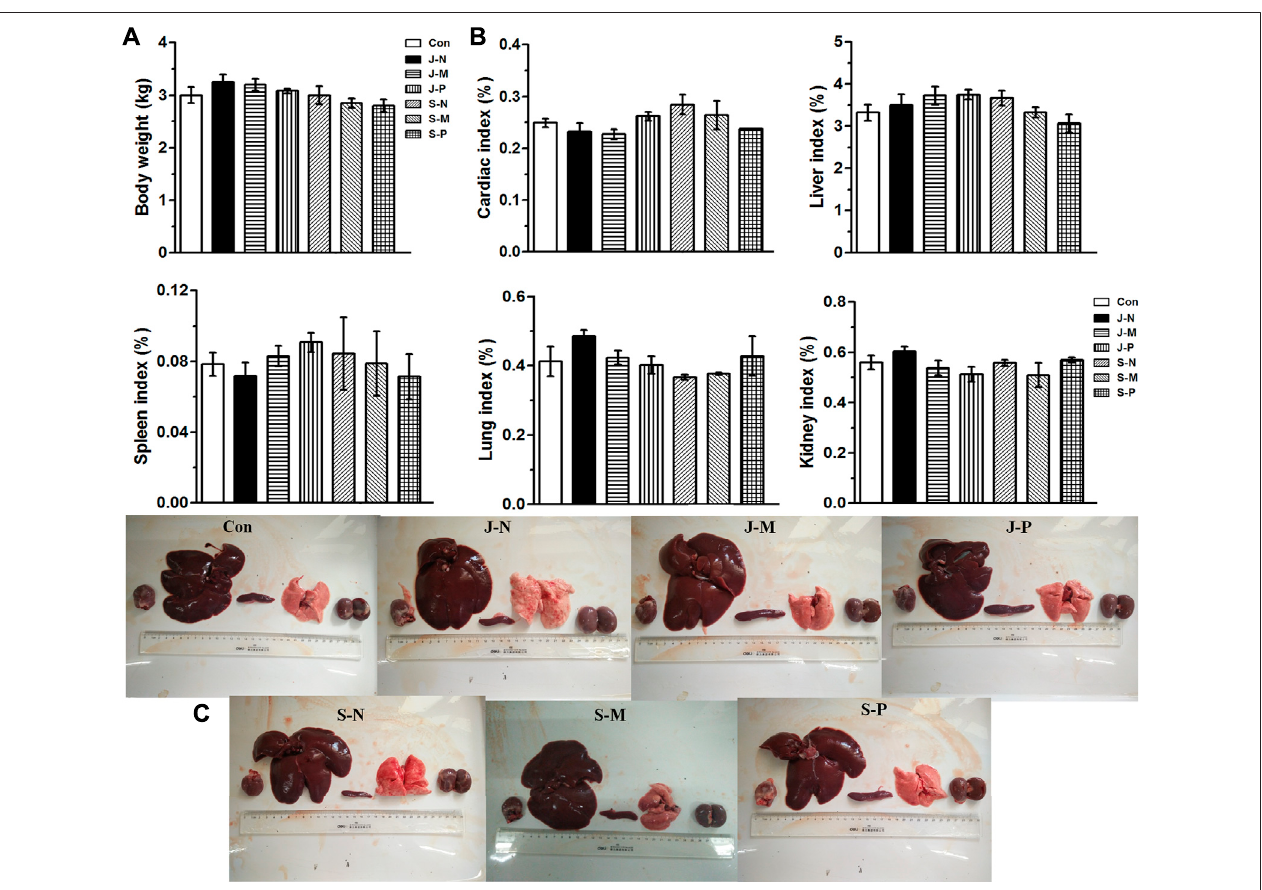
FIGURE6| EffectsofdifferentPALsat30 daysafterinjectionon (A) bodyweight; (B) organcoef fi cient,includingcardiacindex,liverindex,spleenindex,lungindex, and kidneyindex; (C) photographsofvitalorgans(heart,liver,spleen,lungs, andkidneys)inNewZealandrabbits(n (cid:2) 3rabbits/group, mean ± SEM).Thecontrolandsix treatment groups (Con, J-N, J-M, J-P, S-N, S-M, and S-P) are as described in Experimental setup and methods.